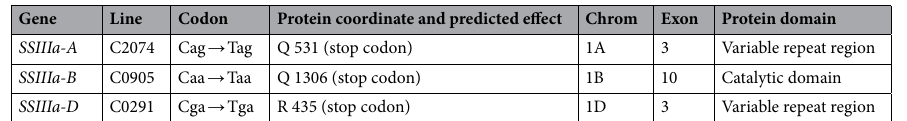
Table 1. Selected mutations for SSIIIa homoeologues. Line is the mutant number in the TILLING population (e.g., C2074 = Cadenza 2074). Codon is the sequence of the control (left) and mutant (right) codons; the uppercase letter indicates which base was mutated. Protein coordinate includes the affected amino acid reside and the position based on deduced amino acid sequences from SSIIIa genomic DNA in the Cadenza cultivar. Chrom is the homoeologous chromosome. Protein domain is based on the defined proteins domains described in Li et al.